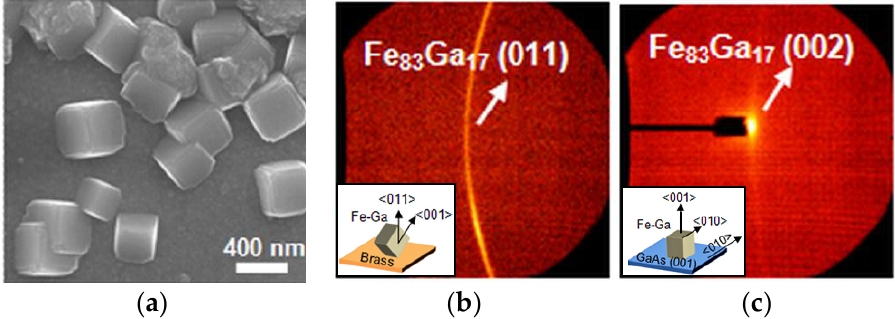
Figure 5. Galfenol grown with slow deposition rates onto ( a ) brass substrates, resulting in ( b ) primarily cube on edge texturing. ( c ) Although some grains were observed with low-energy (110) orientations, a majority of the grains were epitaxially oriented on GaAs. Reproduced from [13], with the permission of AIP Publishing.